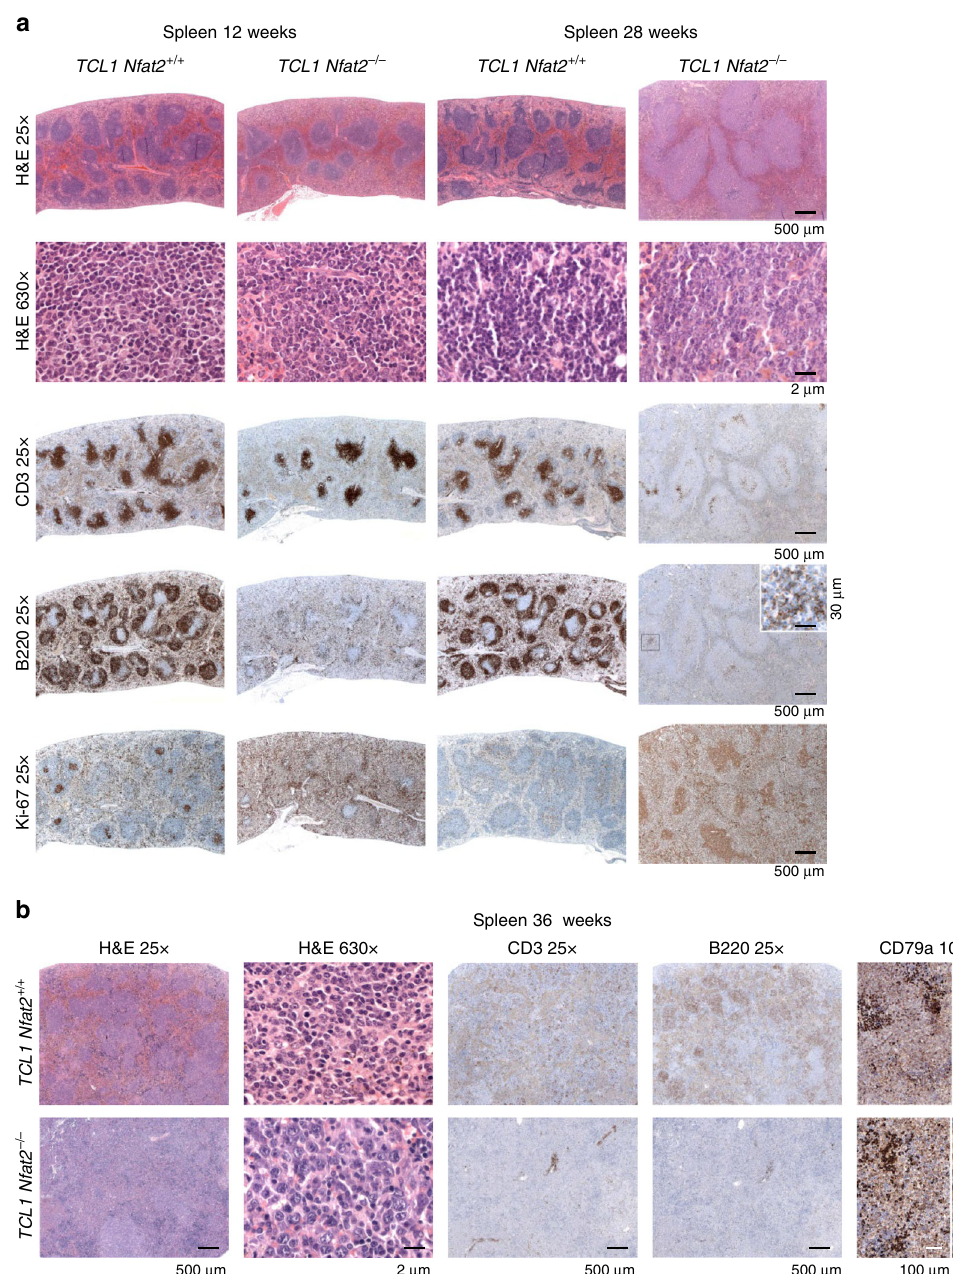
Fig. 4 Nfat2 ablation leads to histologic transformation of CLL to aggressive disease. a H&E staining of paraf fi n-embedded spleen sections of one representative TCL1 Nfat2 +/+ and TCL1 Nfat2 − / − mouse at 12 and 28 weeks of age ( upper panels ) and immunohistochemical staining for CD3, B220 and Ki-67 ( lower panels ). For higher magni fi cation of B220 and Ki-67 staining and CD79a staining in TCL1 Nfat2 − / − mice and Staining of Nfat2 +/+ control mice see also Supplementary Fig. 6. b H&E staining of paraf fi n-embedded spleen sections of representative TCL1 Nfat2 +/+ and TCL1 Nfat2 − / − mice and immunohistochemical staining for CD3, B220 and CD79a at an age of 36